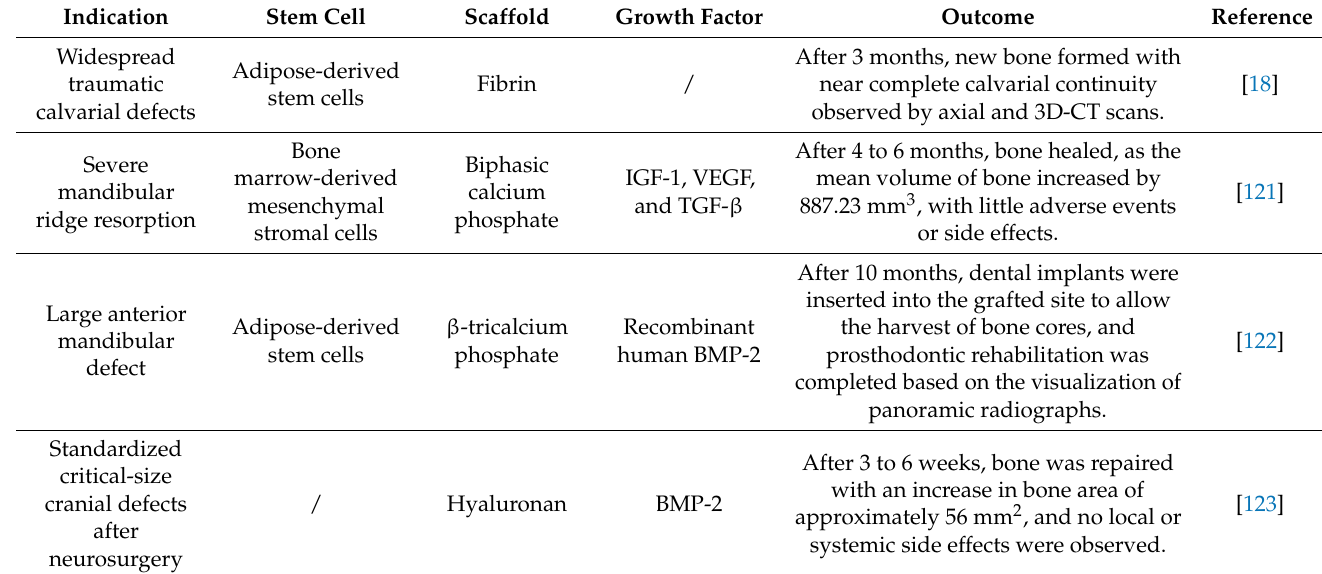
Table 2. Clinical application of bone tissue